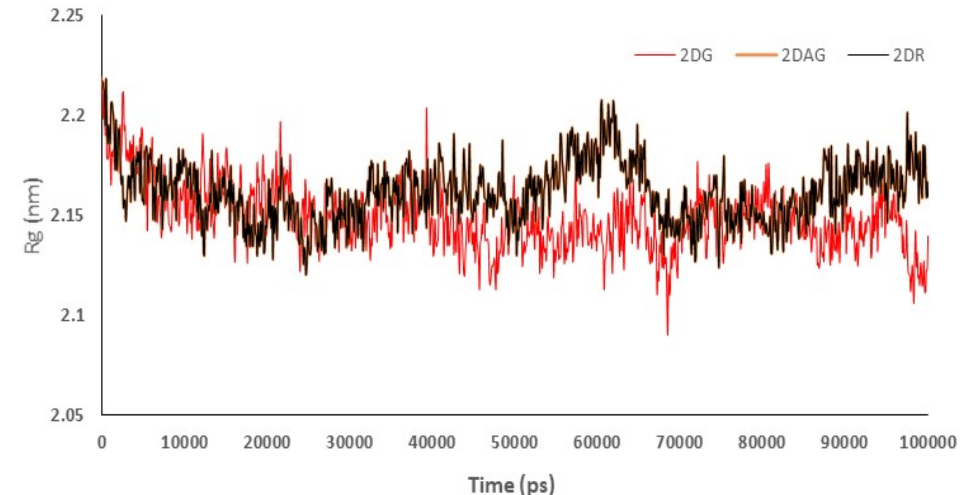
Figure 5. Trajectory of radius of gyration for the main protease of SARS-CoV-2 with 2-deoxy-D-ribose